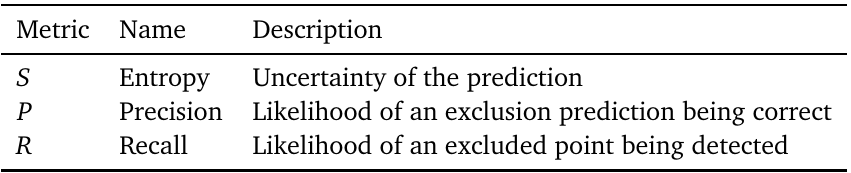
Table 1: Metrics utilised to determine the performance of the O